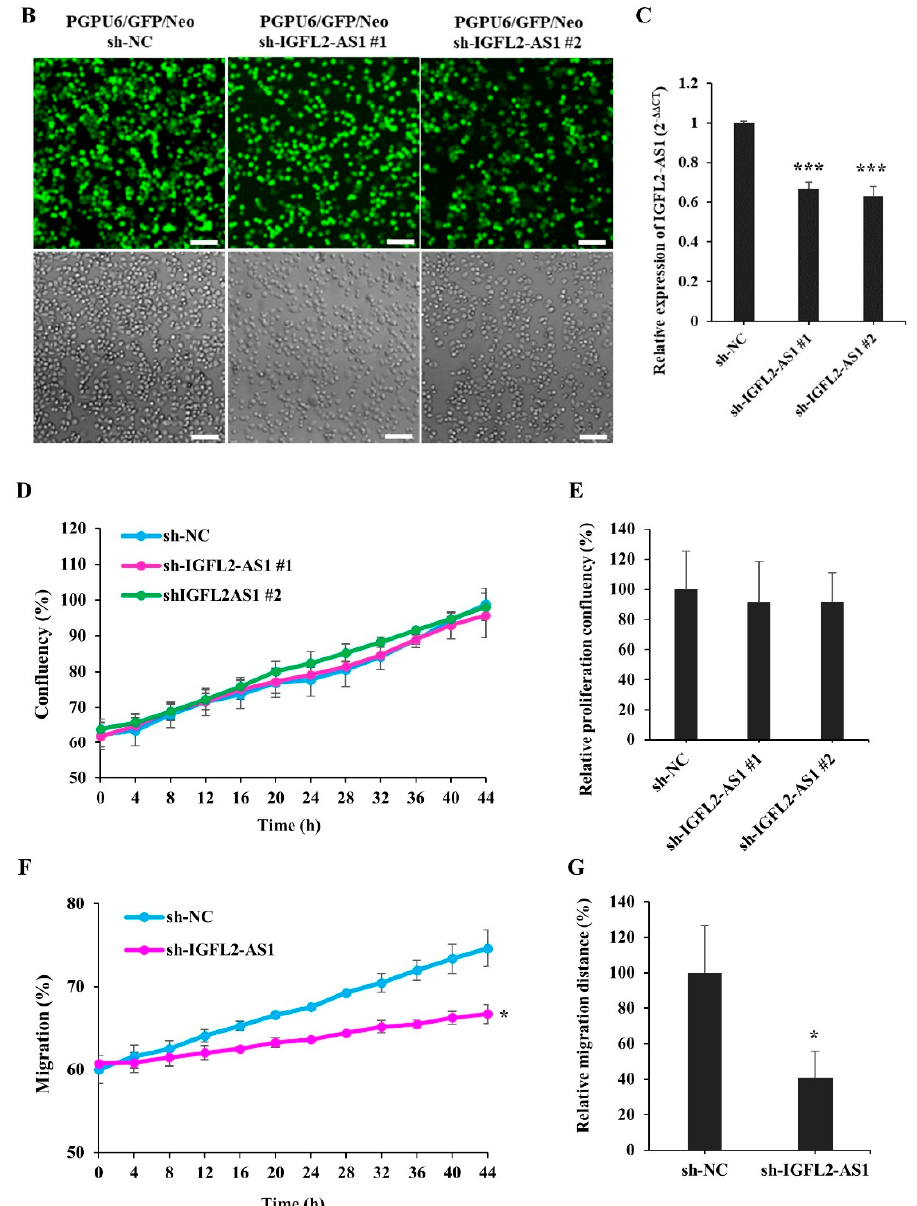
Figure 2. Generation and characterization of a CRC cell line stably transfected with sh-IGFL2-AS1. ( A ) Schematic depicting the establishment of stable cell lines. HT29 cells were transfected with the shRNA-expressing plasmids, pGPU6/GFP/Neo-sh-NC (sh-NC) and pGPU6/GFP/Neo-sh-IGFL2- AS1 (sh-IGFL2-AS1). After incubating transfected HT29 cells with G418 for 2 weeks, individual colonies were isolated. ( B ) GFP fluorescence (upper panels) and brightfield (lower panels) images of the indicated cell lines are shown. Scale bar: 400 µ m. ( C ) The relative level of IGFL2-AS1 transcripts, measured using qRT-PCR. The graph depicts IGFL2-AS1 transcript levels in the indicated cell lines. Data are normalized to those of the sh-NC-HT29 cell line. ( D ) Proliferation rates of the indicated cell lines, measured using a Celloger Mini Plus time-lapse microscopy system. The graph shows proliferation rates calculated from digital images acquired from the same field over 48 h. ( E ) Graph showing the proliferation rates of the indicated cell lines after monitoring for 48 h. ( F ) Wound-healing assays performed using the indicated cell lines. The scratched area was monitored using a time-lapse microscope. The graph shows the rate of cell migration measured over a period of 48 h. ( G ) Graph showing wound-healing assays for the indicated cell lines, monitored after 48 h. Data are presented as means ± SD. Asterisk indicates the followings: * p < 0.05, *** p <